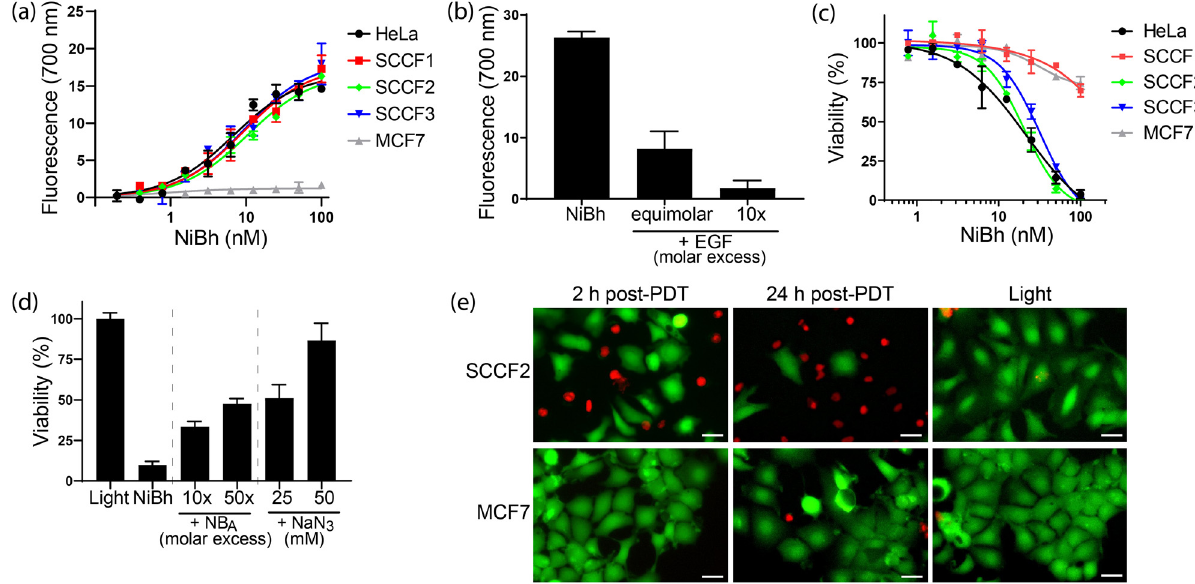
Figure 4: Specific binding and potency of NiBh. (a) A binding assay was performed with NiBh using the panel of human and feline cell lines (HeLa, SCCF1, SCCF2, SCCF3, and MCF7 cells). The graph displays the saturation binding curves of NiBh to each cell line from which K D values were calculated. (b) Binding of NiBh (10 nM) to SCCF2 cells in the absence or presence of equimolar concentration and 10 × molar excess of EGF. The fl uorescence corresponding to bound NiBhundereachconditionisdisplayedinthegraph.(c)NB-PDTusingNiBhwasperformedonthepanelofcelllinesand,onedaylater,viability was assessed. The graph shows viability curves for each cell line, in percentage relative to untreated cells. (d) NB-PDT (50 nM NiBh) was performed on SCCF2 cells in the absence or presence of a molar excess of unconjugated NB A . NB-PDT was also performed in the presence of sodium azide (NaN 3 ). A control consisting of cells exposed to light, but no conjugate, was included. Cell viability was assessed the next day and represented as percentage relative to untreated cells. (e) NB-PDT (50 nM NiBh) was performed on SCCF2 or MCF7 cells and cells stained with calcein and propidium iodide to visualize live (green) and dead (red) cells, respectively. A control in which light was applied, but no conjugate, was taken along. Images were taken 2 and 24 h after NB-PDT. Scale bar, 20